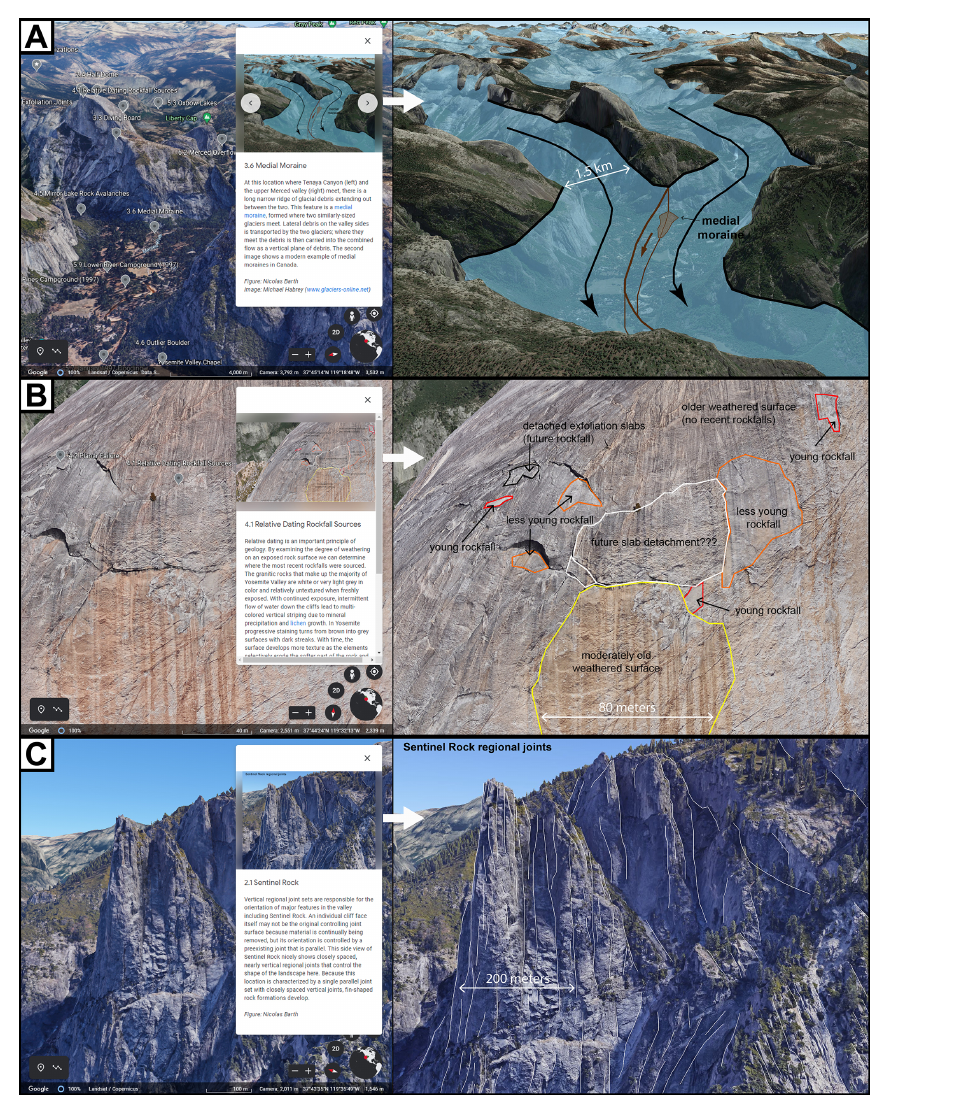
Figure 3. VFT stops highlighting learning through guided exploration. Left panels show the VFT stop view in © Google Earth Web; right panels show the corresponding annotated image embedded in the stop’s description. VFT stops showcase (a) the medial moraine at the junction of Tenaya Creek and Merced River, (b) exfoliation-related rockfall sources of different ages on the slopes of Half Dome, and (c) regional joints exposed in the cliff faces of Sentinel Rock. By simulating the dynamic view in a figure, the viewer can better visualize the key features emphasized. In each instance, the dynamic view encourages the viewer to magnify the image to see a feature or search the surrounding area for similar